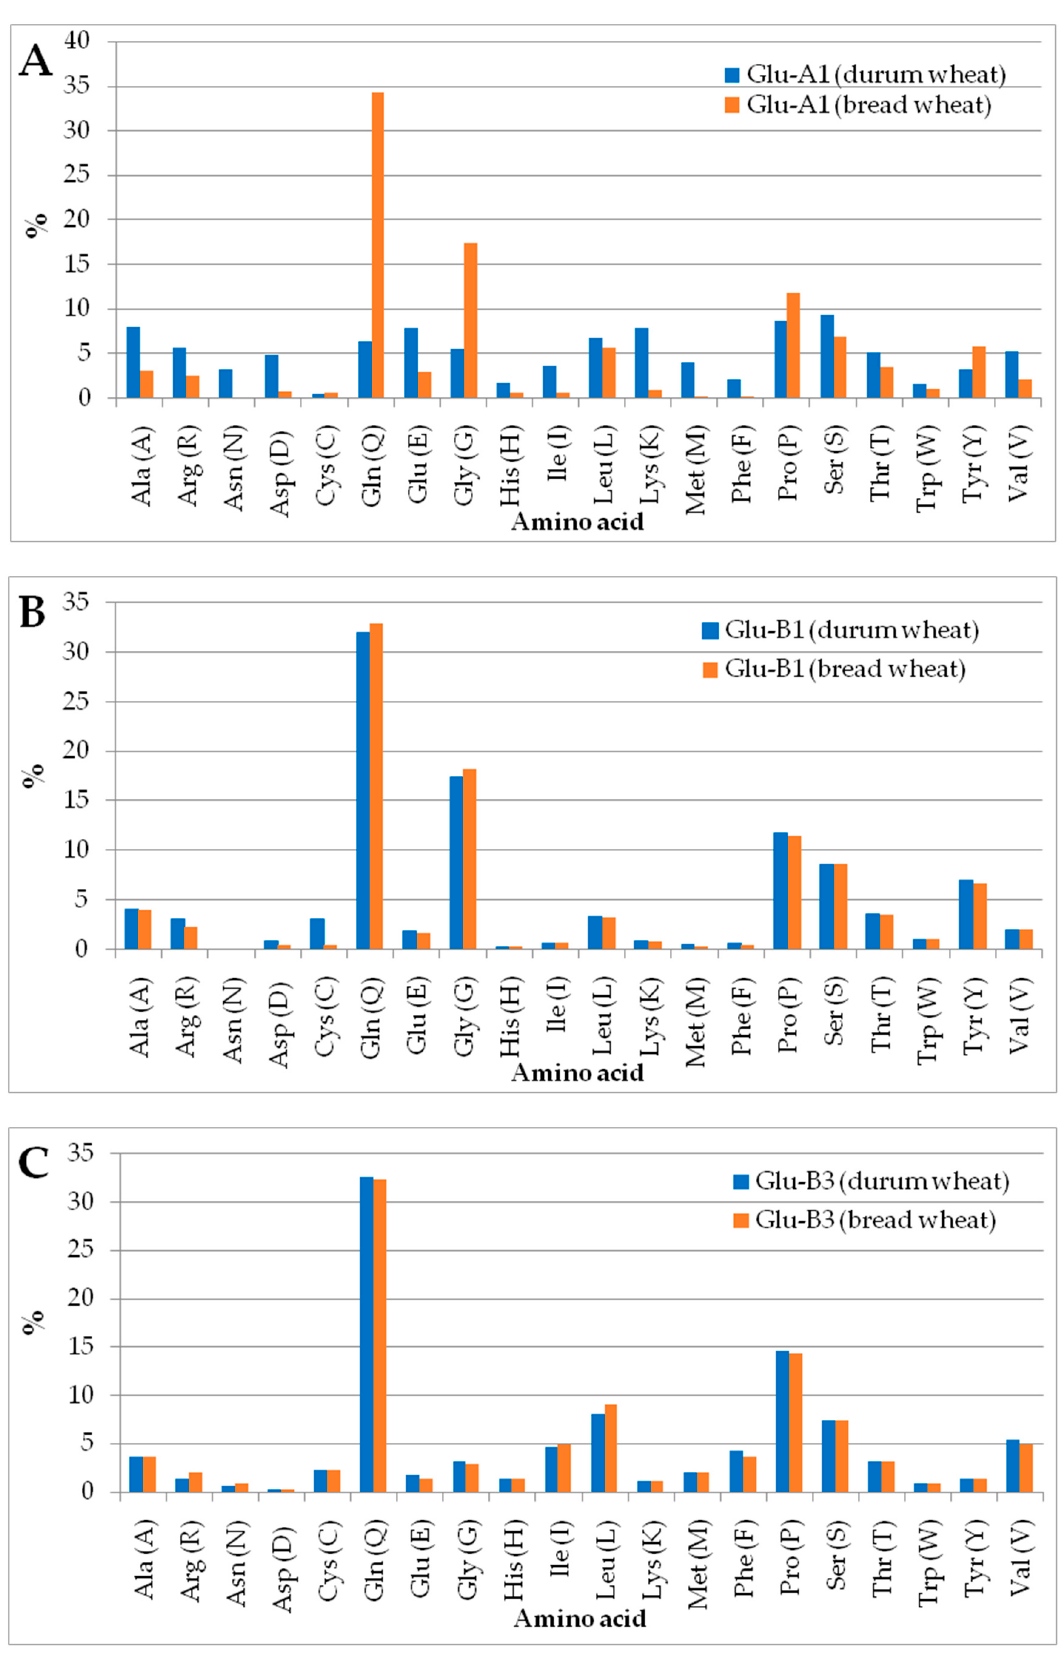
Figure 6. Amino acid composition of the Glu-A1 ( A ), Glu-B1 ( B ), and Glu-B3 ( C ) of durum and bread